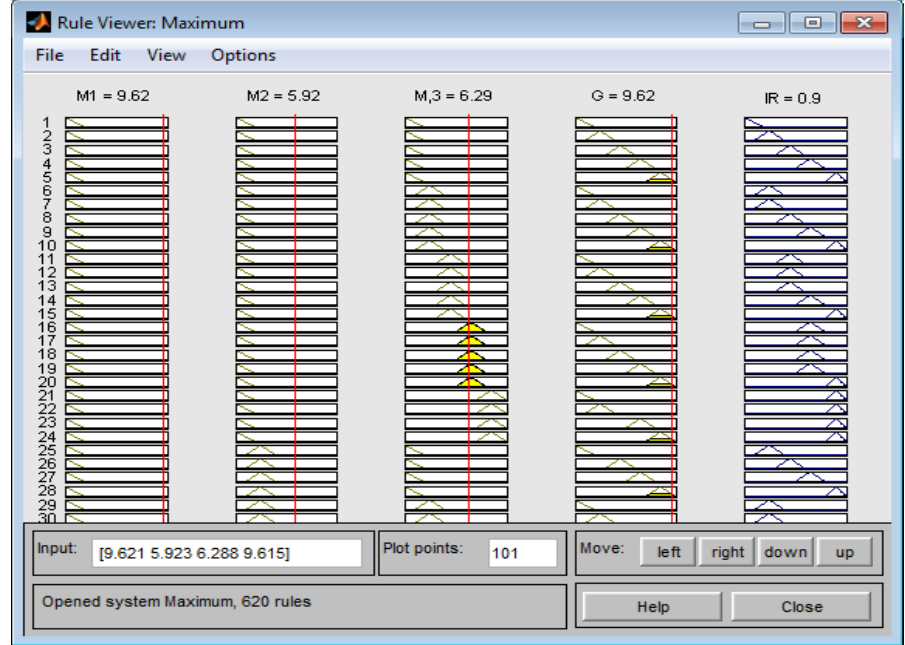
Figure 15. Example of max-based fuzzy rules used in the top-level FIS.